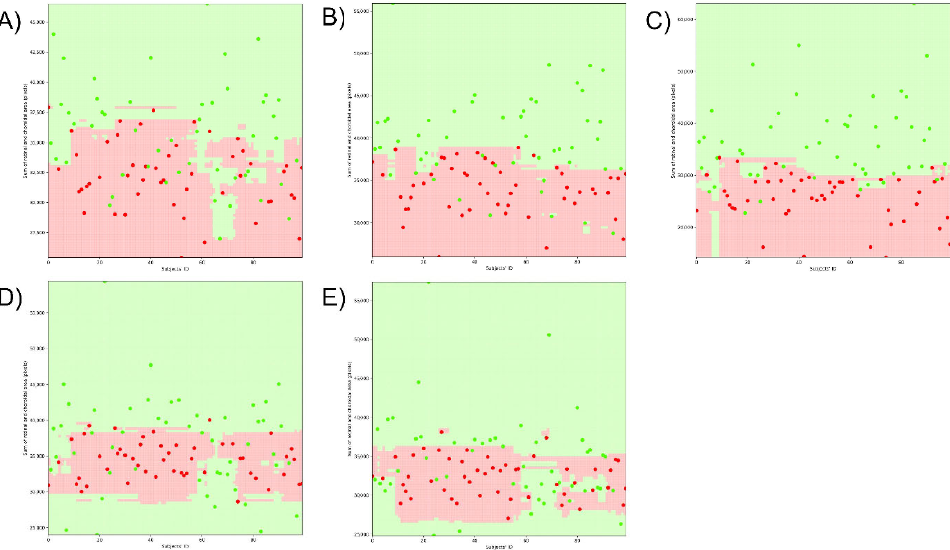
Figure 8. Classification of each segment in the ML model. The red and green dots and areas indicate the abnormal and normal eyes classified by the ML model in each segment. The accuracies of each segment were ( A ) 83% for segment 1 (peripheral temporal retina), ( B ) 87% for segment 2 (temporal perimacular area), ( C ) 96% for segment 3 (central macular area), ( D ) 88% for segment 4 (nasal perimacular area), and ( E ) 89% for segment 5 (peripheral nasal retina). Abbreviation: ML, machine